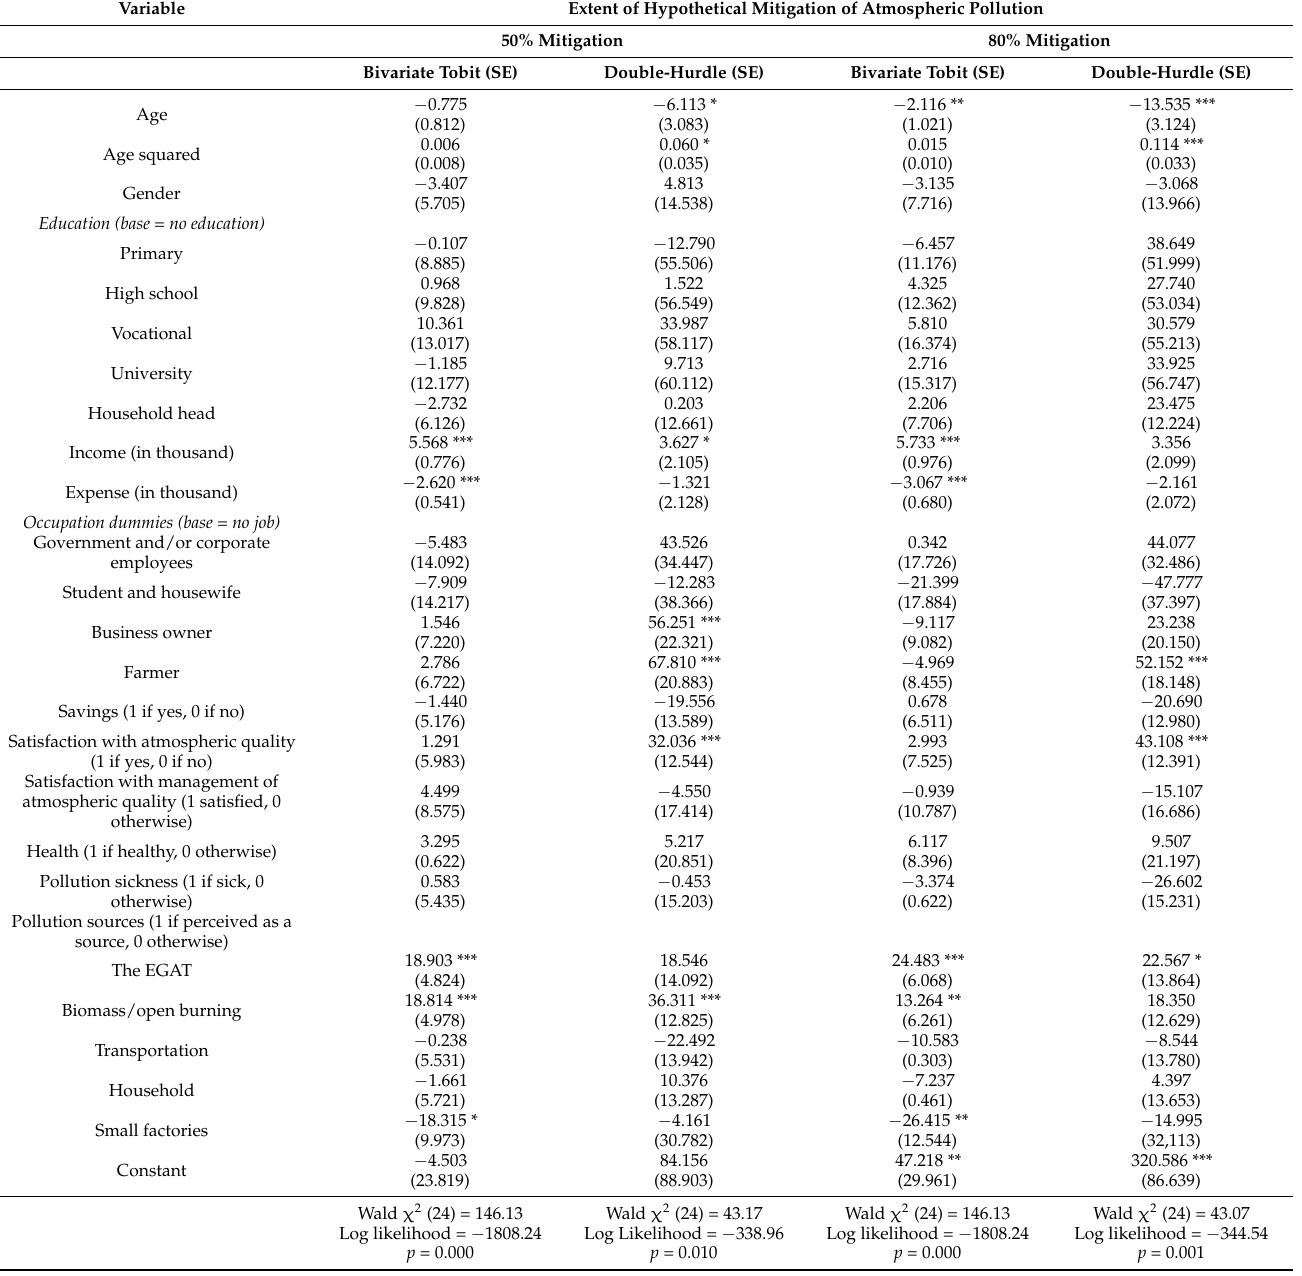
Table 11. Individual factors associated with the values of individual willingness to pay (WTP) for atmospheric pollution mitigation in Mae Moh: the bivariate tobit and the second tier of the double hurdle regressions ( n = 200). Variable Extent of Hypothetical Mitigation of Atmospheric Pollution 50% Mitigation 80% Mitigation Bivariate Tobit (SE) Double-Hurdle (SE) Bivariate Tobit (SE) Double-Hurdle